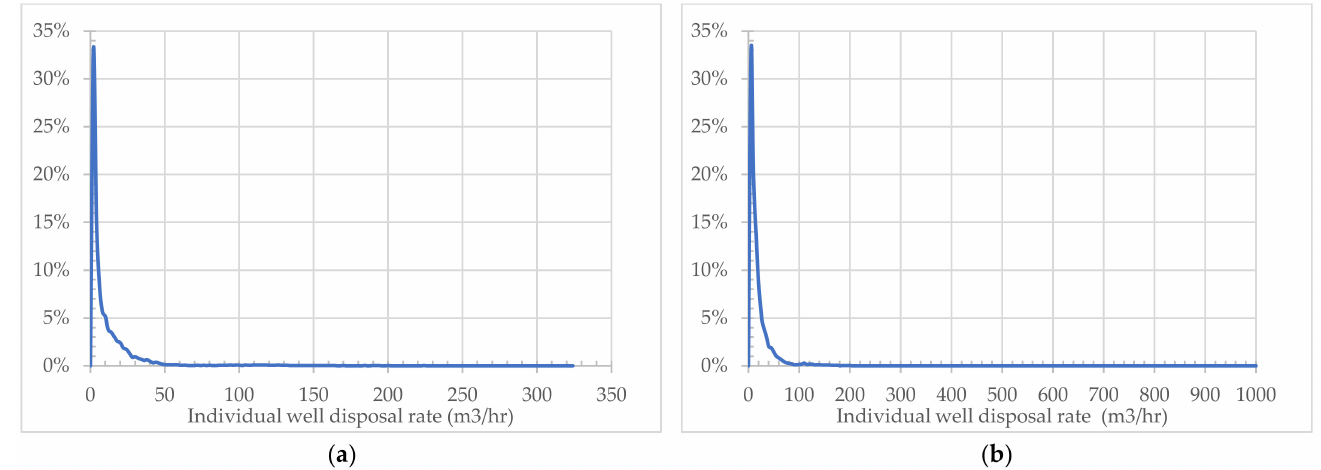
Figure A25. Historical per-well water injection rate ( X -axis) frequency ( Y -axis) distributions (January 1962–December 2022) in ( a ) the Wabamun Formation; ( b ) the Nisku Formation.